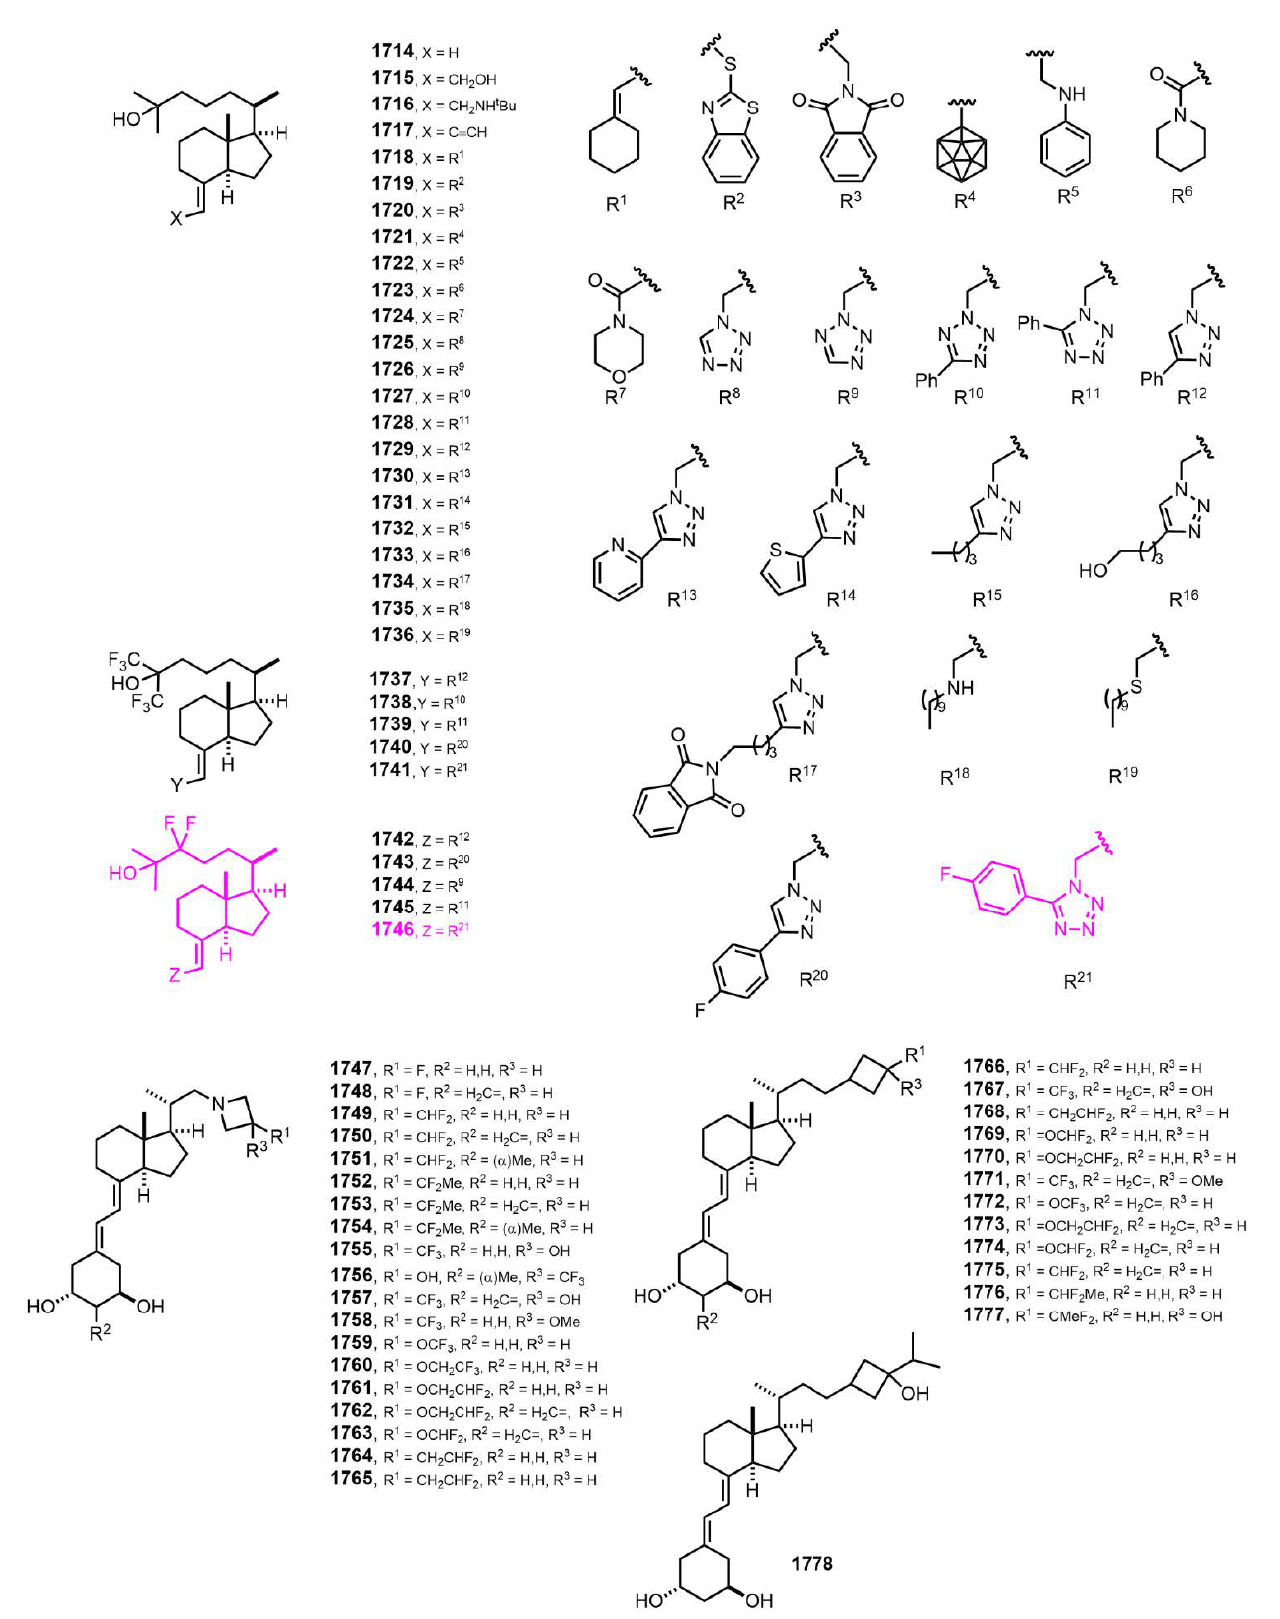
Figure 31. (2021–2022)